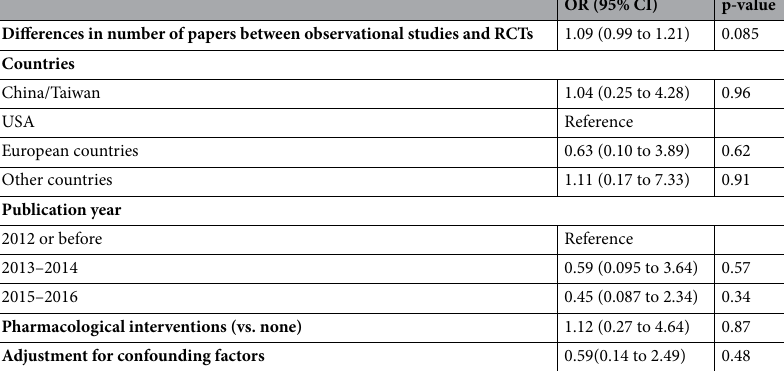
Table 3. Predictors of discrepancies in results between observational studies and randomized control trials. Adjusted for differences in the number of primary articles between observational studies and RCTs, publication year, country of first author, and pharmacological intervention. OR odds ratio, CI confidence interval, USA United States of America.